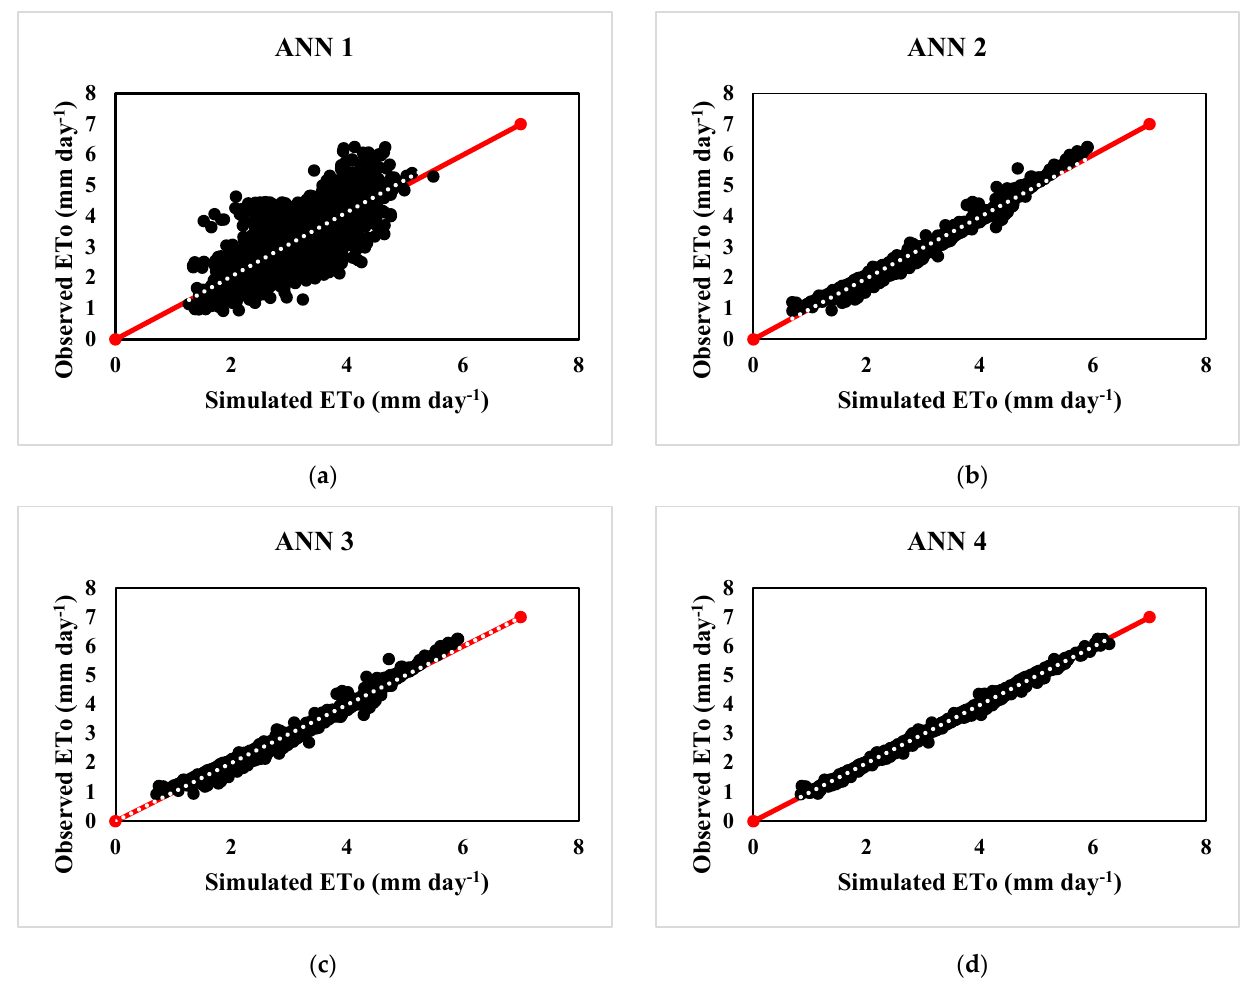
Figure 5. Comparison of the daily observed and simulated ET 0 by ANN models; ( a ) ANN 1; ( b ) ANN 2; ( c ) ANN 3; ( d ) ANN 4. (Cameron Highlands station). Table 3. Statistical evaluation of DFR model with different meteorological variables for testing subsets.